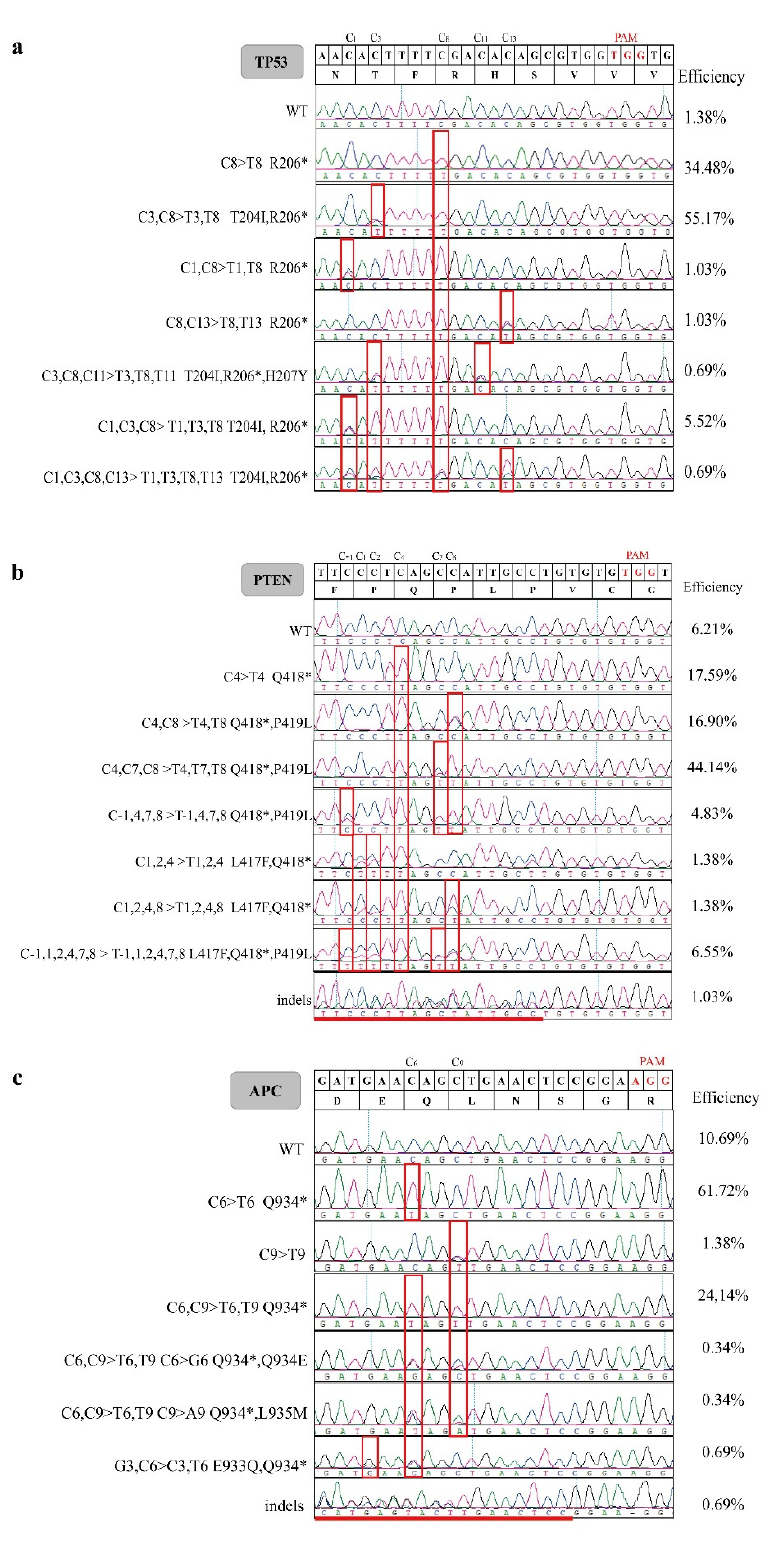
Figure 3. Base substitutions induced by the hA3A-BE3-Y130F system. ( a – c ) Sanger sequencing chromatograms of single-cell colonies showing gene modifications at TP53 ( a ), PTEN ( b ), and APC ( c ) loci. The base substitutions are highlighted in red boxes and * represents stop codons.